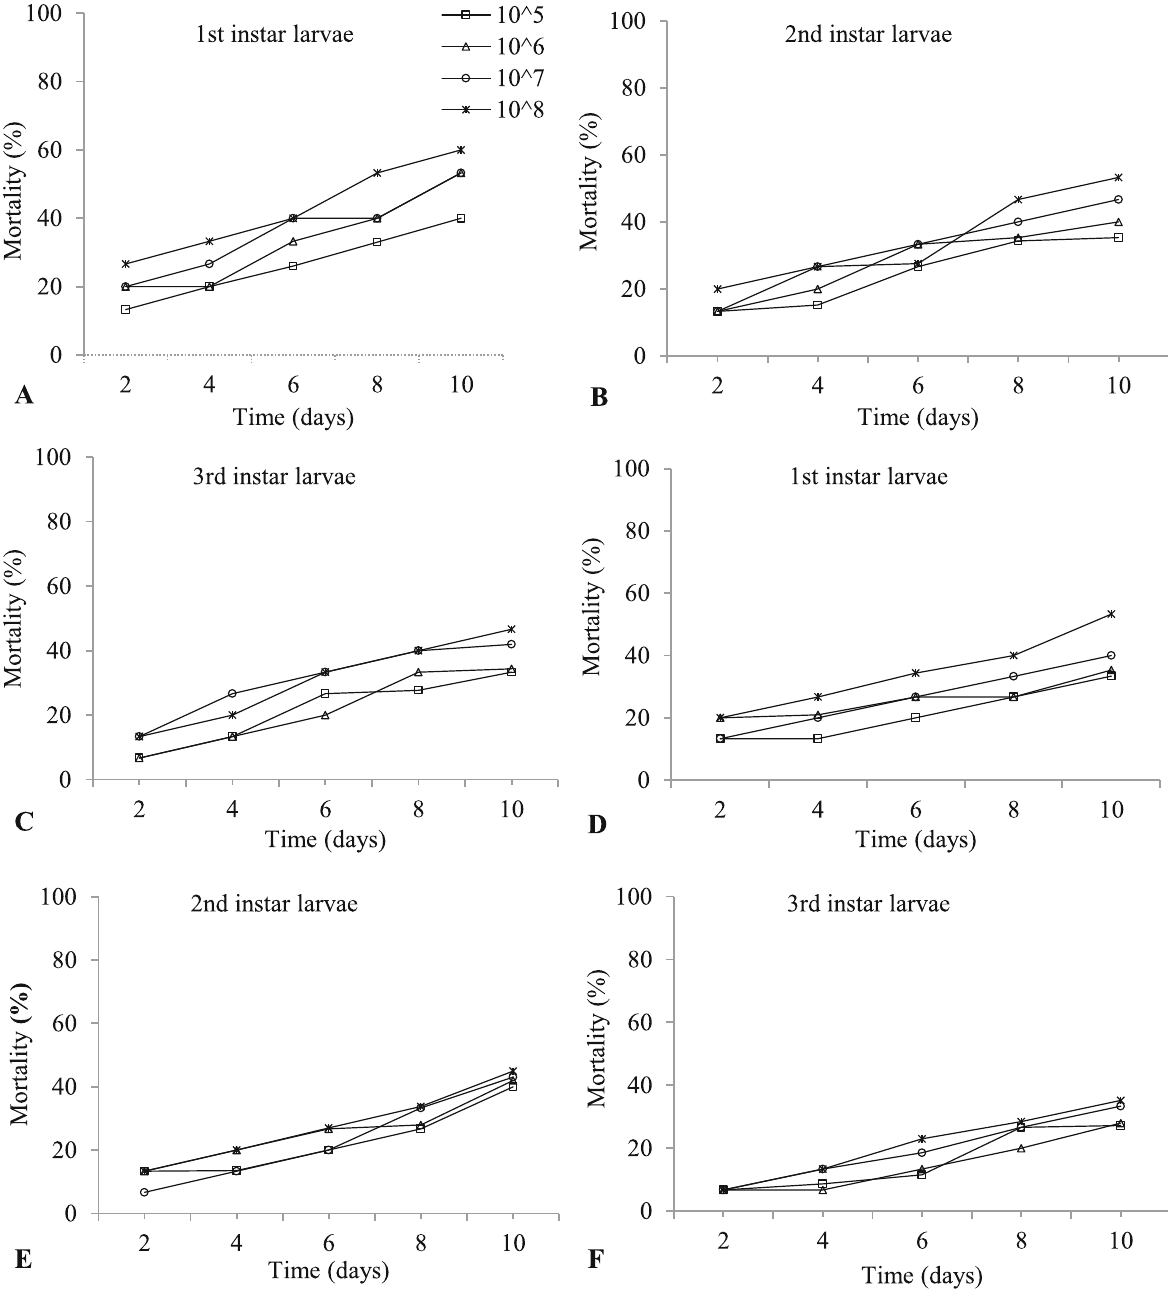
Fig. 2 The mortality trend of different larval instars of Xanthogaleruca luteola treated by Metarhizium anisopliae during different times using immersion ( a, b, c ) and spraying ( d, e, f )